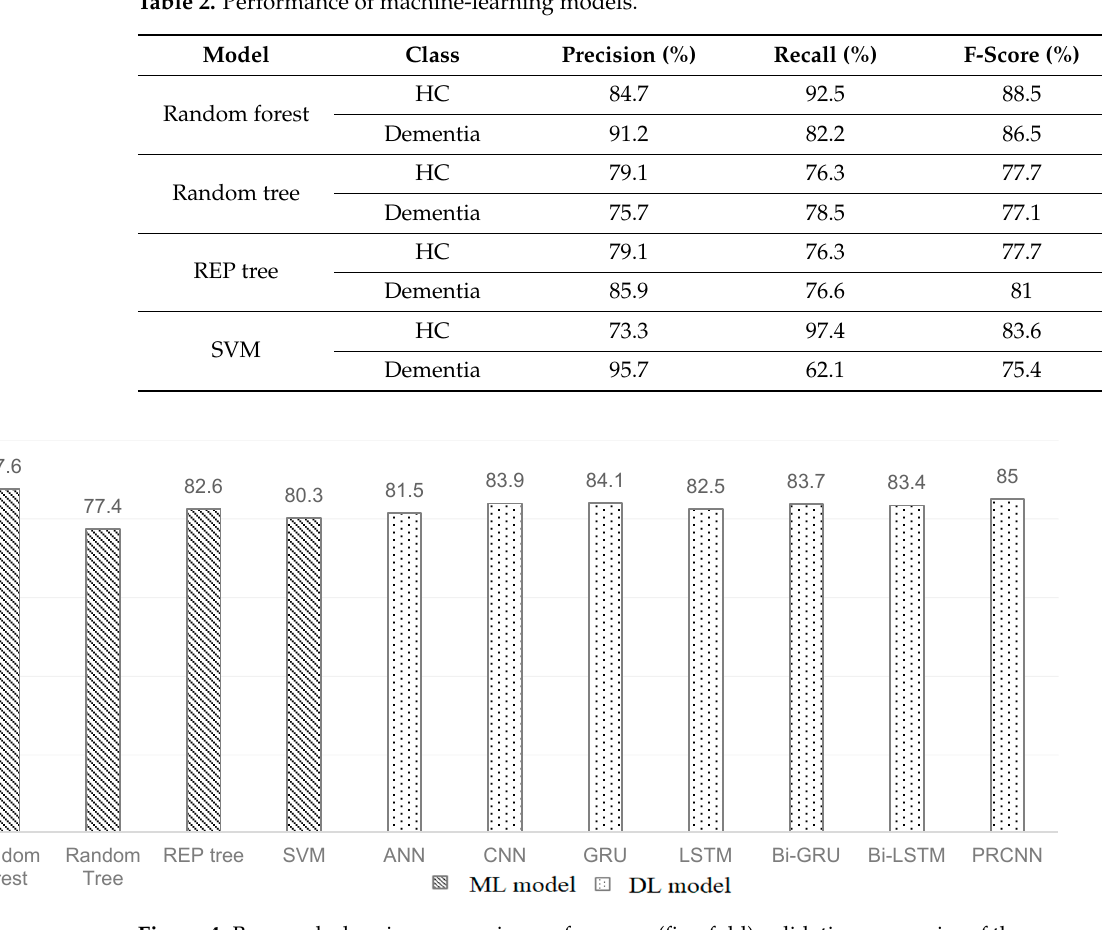
Figure 4. Bar graph showing comparisons of average (five-fold) validation accuracies of the proposed ML and DL models.